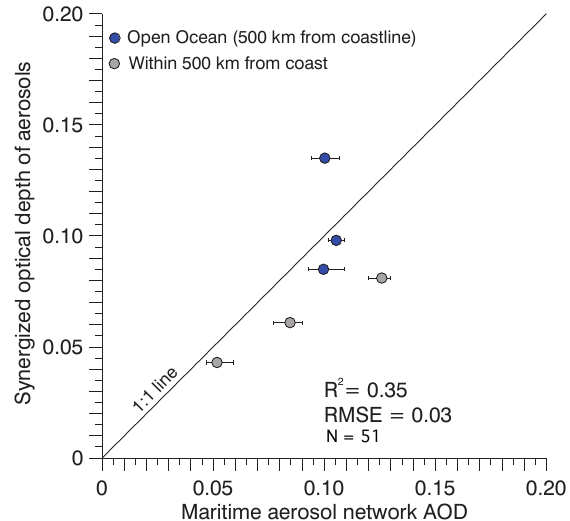
Figure 8. Scatter plot comparing the aerosol optical depth from SODA ( y axis) and AERONET Maritime Aerosol Network ( x axis). Blue circles represent locations that are at least 500km from a coast- line and are considered to be “open